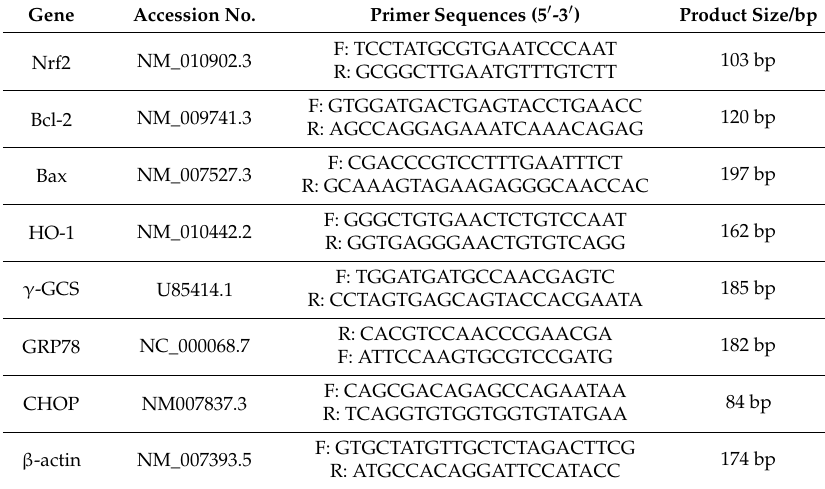
Table 1. Primers for real-time PCR analyses.